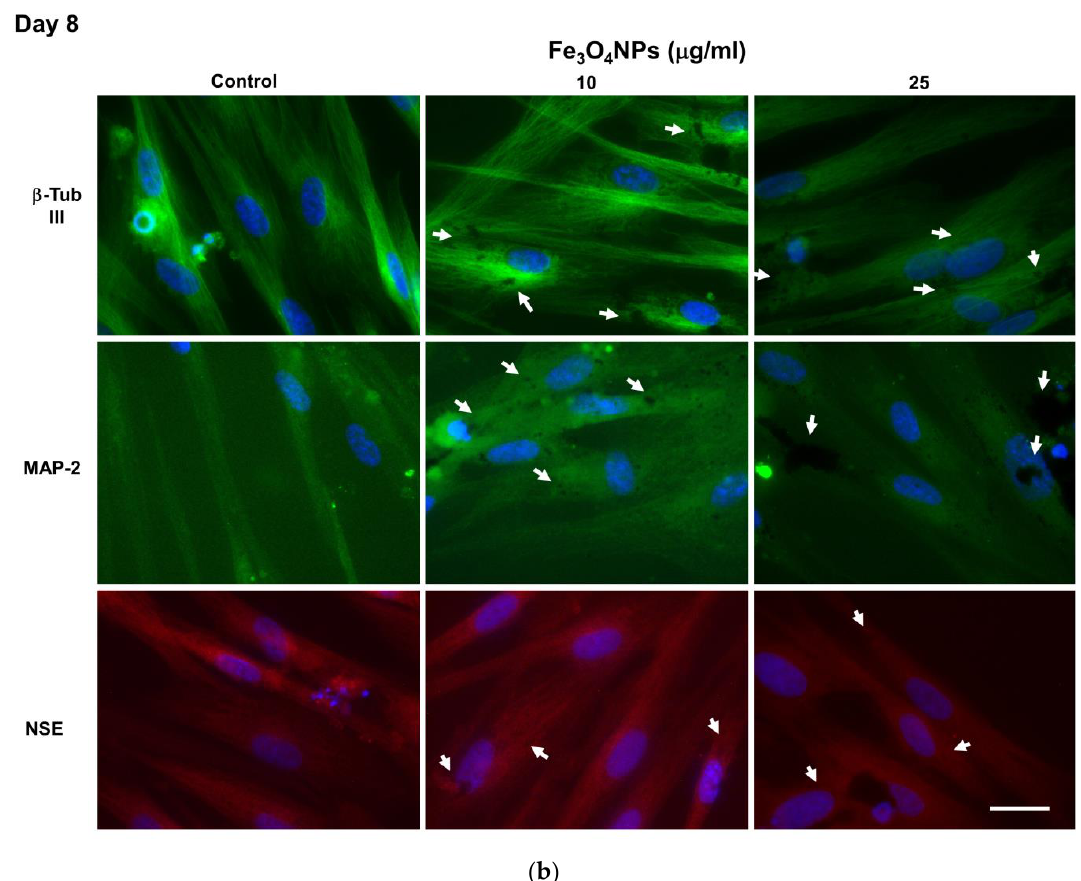
Figure 7. Neuronal marker protein expressions in hNLCs cultured with Fe 3 O 4 NPs. Fe 3 O 4 NPs apparently a ff ected the transdi ff erentiation of CL-hMSCs starting from 25 µ g / mL: hNLCs at day 3 ( a ) and day 8 ( b ) of transdi ff erentiation exhibited a decrease of fluorescence intensity of neuron markers such as β -Tub III (green fluorescence), MAP-2 (green fluorescence) and NSE (red fluorescence). Black spots of Fe 3 O 4 NPs (intracellularly and on the cell membrane) were also visible. Nuclei were stained with Hoechst 33258. White arrows indicate Fe 3 O 4 NPs (dark spots). Scale bar: 100 µ m.